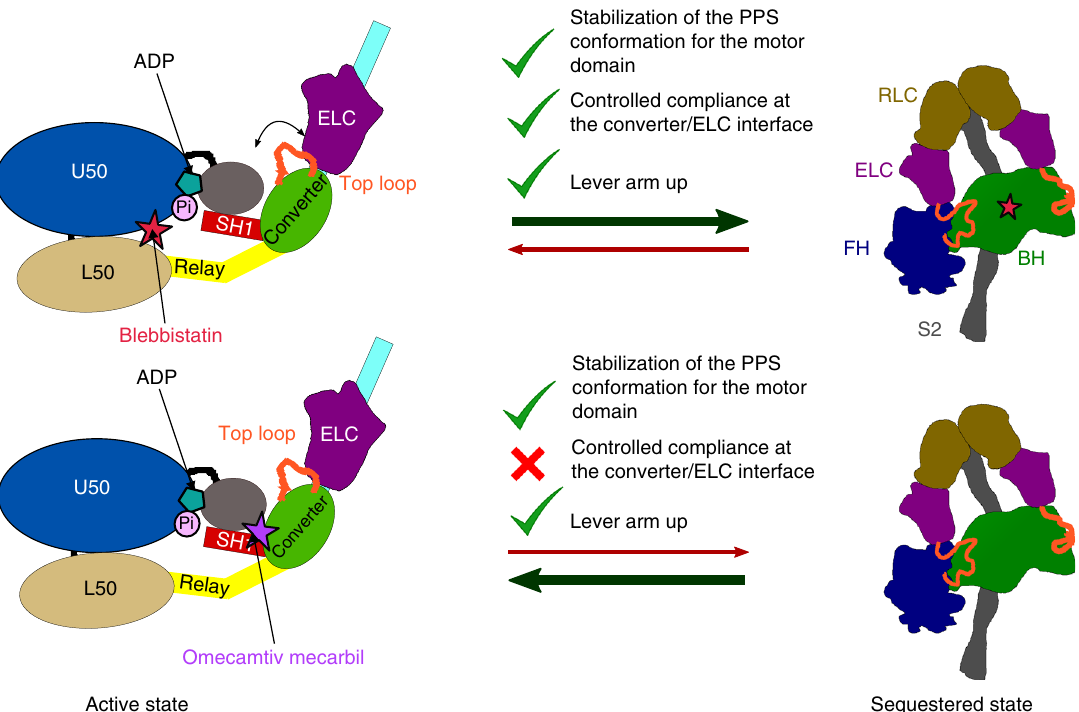
Fig. 6 Antagonistic effects of omecamtiv mecarbil (OM) and blebbistatin (BS) on the sequestered state. Schematic representation of the effects of the inhibitor BS and the activator OM. On top: BS occupies a pocket within the motor domain core, close to the active site. Occupation of this pocket by BS allows to stabilize the PPS conformation without any effect on the local compliance of the lever arm required to form the sequestered state. Thus, BS binding is compatible with the IHM and favors the formation of the sequestered state. On the bottom: OM occupies a pocket at the interface between the converter and the N-ter subdomain 11 . This pocket is expected to decrease the compliance of the converter/ELC interface and constrain the lever arm in a particularly primed position. There is thus a loss in the compliance required to form the sequestered state if OM is bound to the heads of the Myo2 dimer. This explains why OM is incompatible with the formation of the sequestered